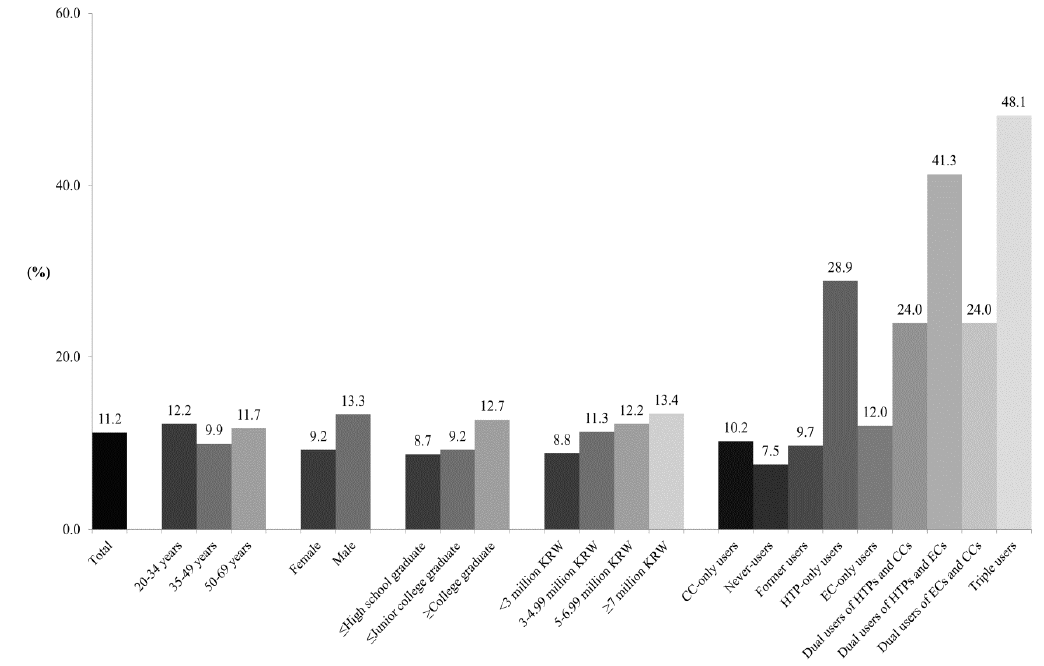
Figure 2. Frequency of the belief that HTPs aid in smoking cessation. Abbreviations: CCs = combustible cigarettes; HTPs = heated tobacco products; ECs = electronic cigarettes; KRW = Korean Republic Won (KRW 1000 = US Dollar 1). Values are presented as weighted percentages (the weighted % of women was 50).